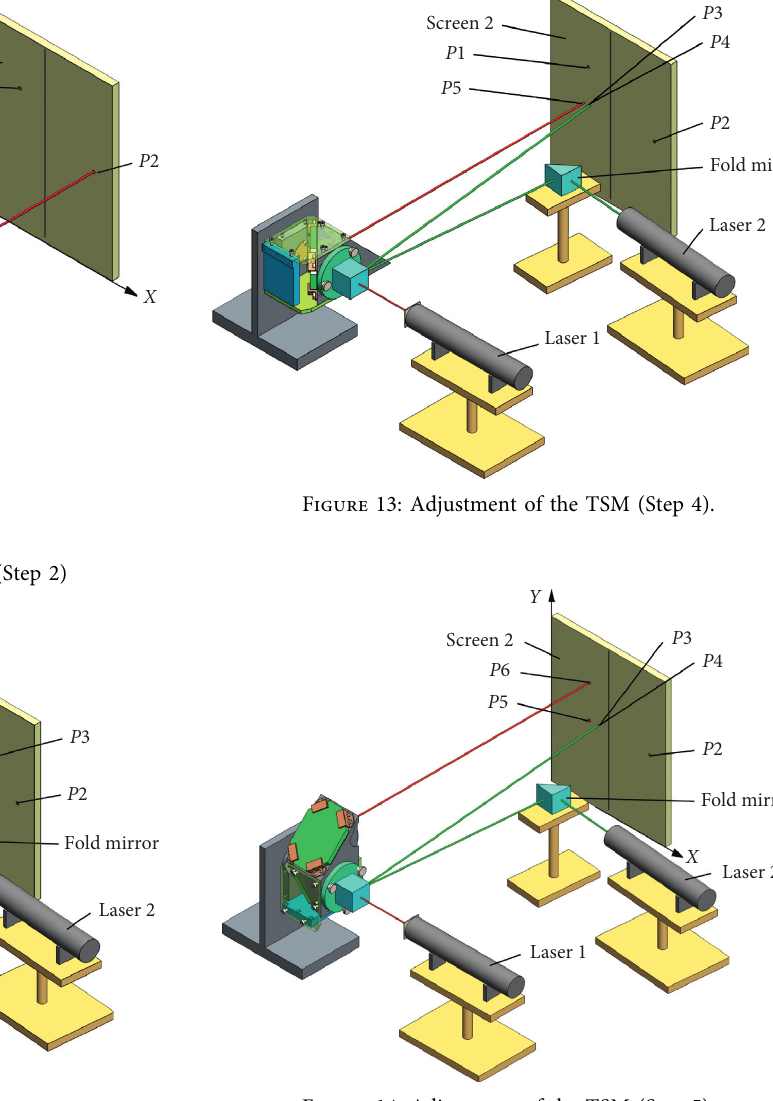
Figure 14: Adjustment of the TSM (Step 5).